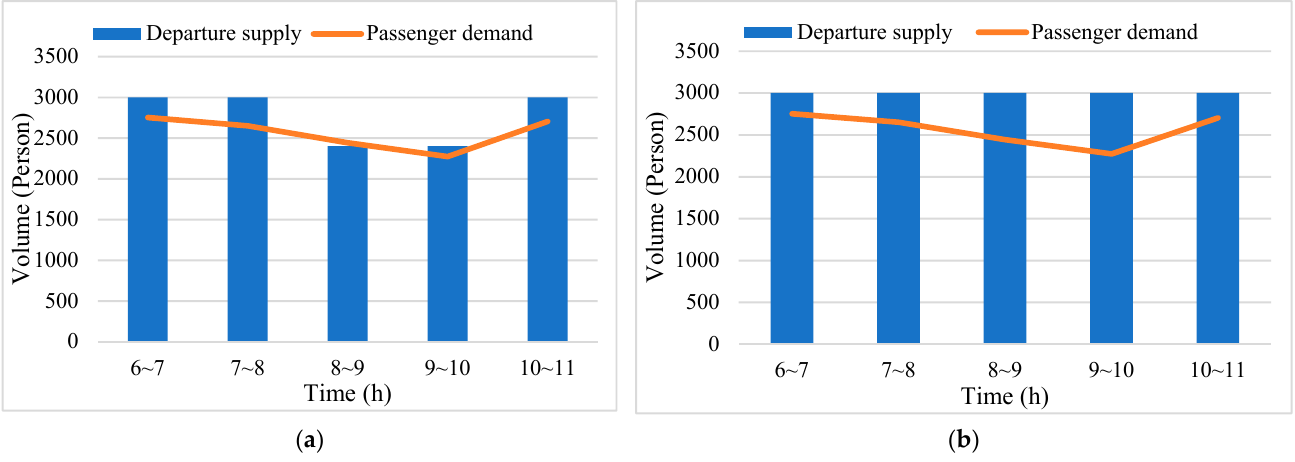
Figure 9. Supply and demand matching diagram under scenario 3. ( a ) Supply and demand matching diagram of multi-cycle train timetable. ( b ) Supply and demand matching diagram of single-cycle train timetable.